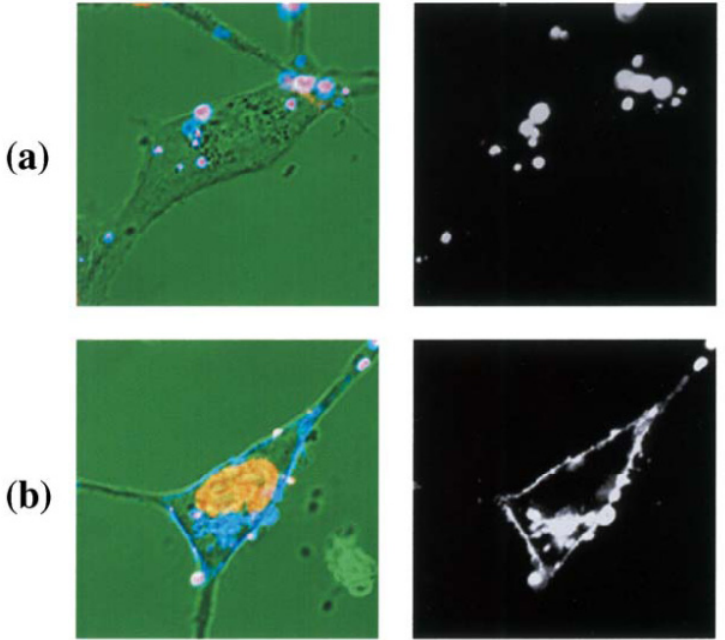
Figure 4. CLSM images of NIH3T3 cells incubated with fluorescence labeled liposome-DNA complex. NIH3T3 cells were incubated with FITC-conjugated oligonucleotides complexed with rhodamine-labeled liposomes composed of OH-Chol without MEL-A ( a ) and with MEL-A ( b ) for 1 h. Fluorescence images of liposome ( right ) and merged images on a transmittance image with pseudo-color (yellow for DNA, blue for liposome, and pink for liposome-DNA-complex) ( left ) are